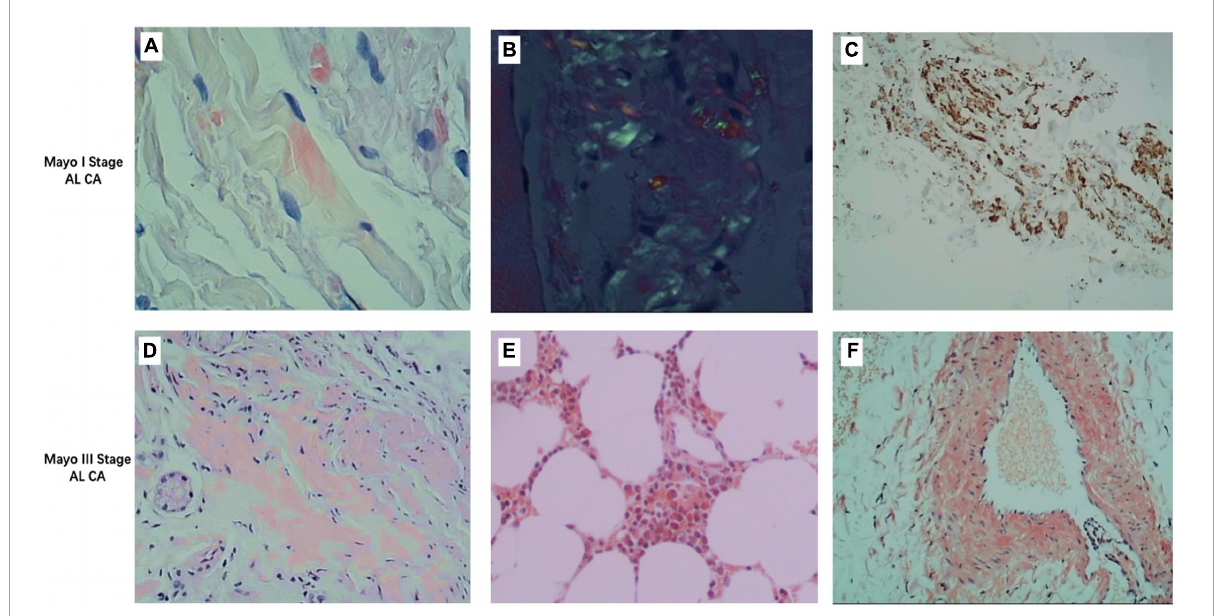
FIGURE1 Representative images of different stages of light chain amyloidosis patients. (A) Congo red stain fluorescence staining of deltoid muscle of a Mayo I stage patient showing red fluorescent bright of amyloid deposit ( × 400). (B) Congo red stain birefringence of (A) under polarized light showing amyloid ( × 400). (C) Immunohistochemistry stains for lambda (+) and kappa (–) light chains in the deltoid muscle of a Mayo I stage patient show amyloid deposits ( × 400). (D) Congo red stain fluorescence staining of the liver of a Mayo III stage patient showing red fluorescent bright of amyloid deposit ( × 400). (E) Congo red stain fluorescence staining of bone marrow stroma of a Mayo III stage patient showing red fluorescent bright of amyloid deposit ( × 400). (F) Congo red stain fluorescence staining of the vascular wall of a Mayo III stage patient showing red fluorescent bright of amyloid deposit ( × 400).